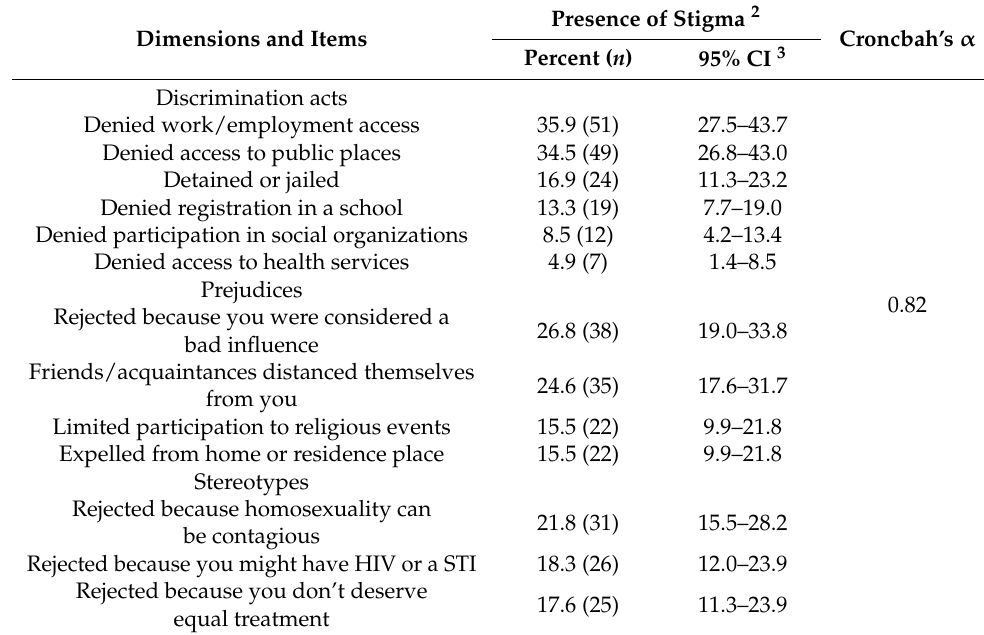
Table 3. Experienced stigma 1 among interviewed men who have sex with men, Manzanillo, Mexico ( n =